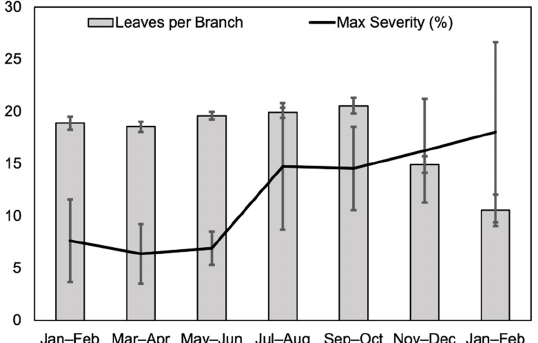
Figure 5. Mean number of leaves per branch as a measure of defoliation, and maximum CLR severity for commercial farms in Kona from 2021–2022. Maximum severity peaked at the end of the harvest, while the mean number of leaves per branch fell by